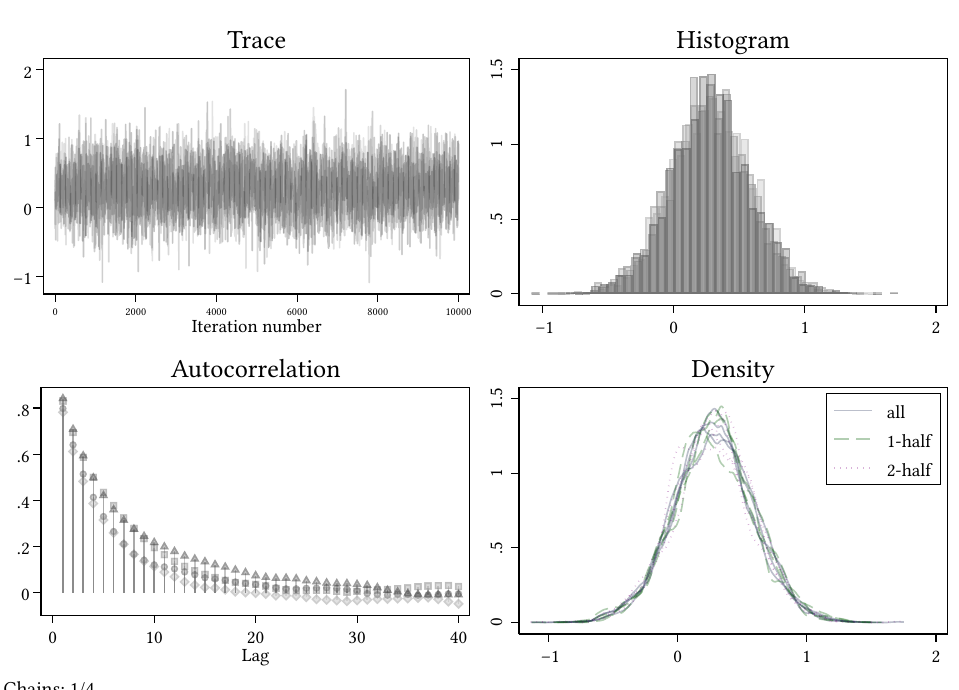
Figure A1. How awareness of the price effect influences the response to the market price. The control group.